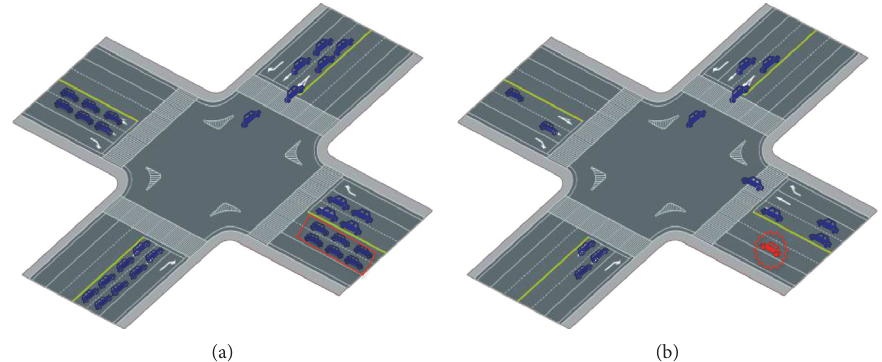
Figure 1: Overflow at intersections: (a) real situation of overflow at intersections and (b) false situation of overflow at intersections.